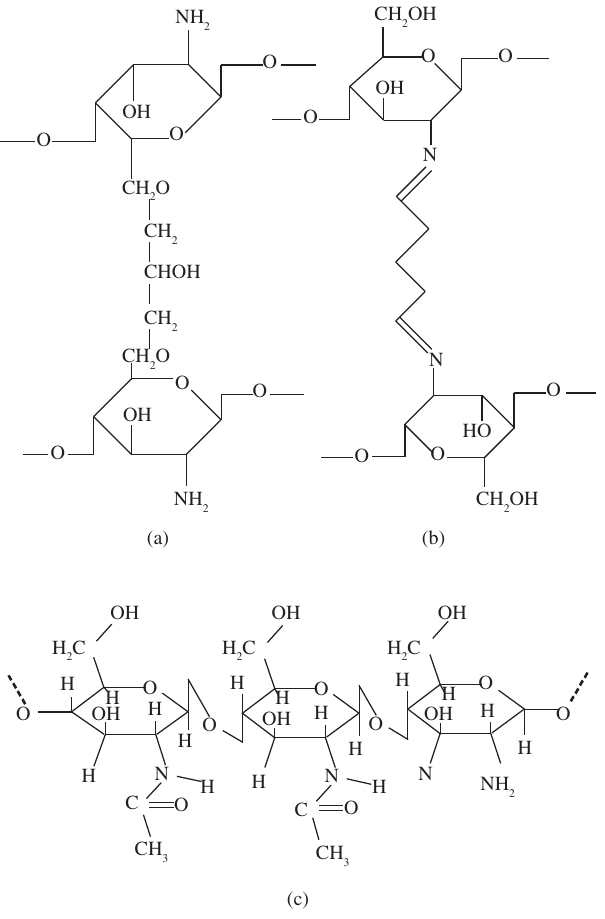
Figure 1. Chemical structures of chitosan modified with: a) epychlorohydrin; b) glutaraldehyde; and c) acetic anhydride.